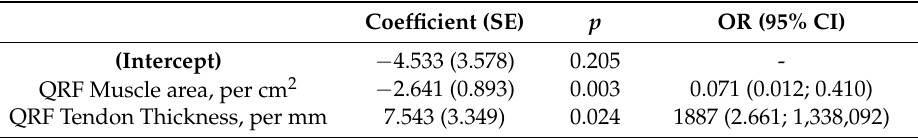
Table 3. Multivariate logistic regression.